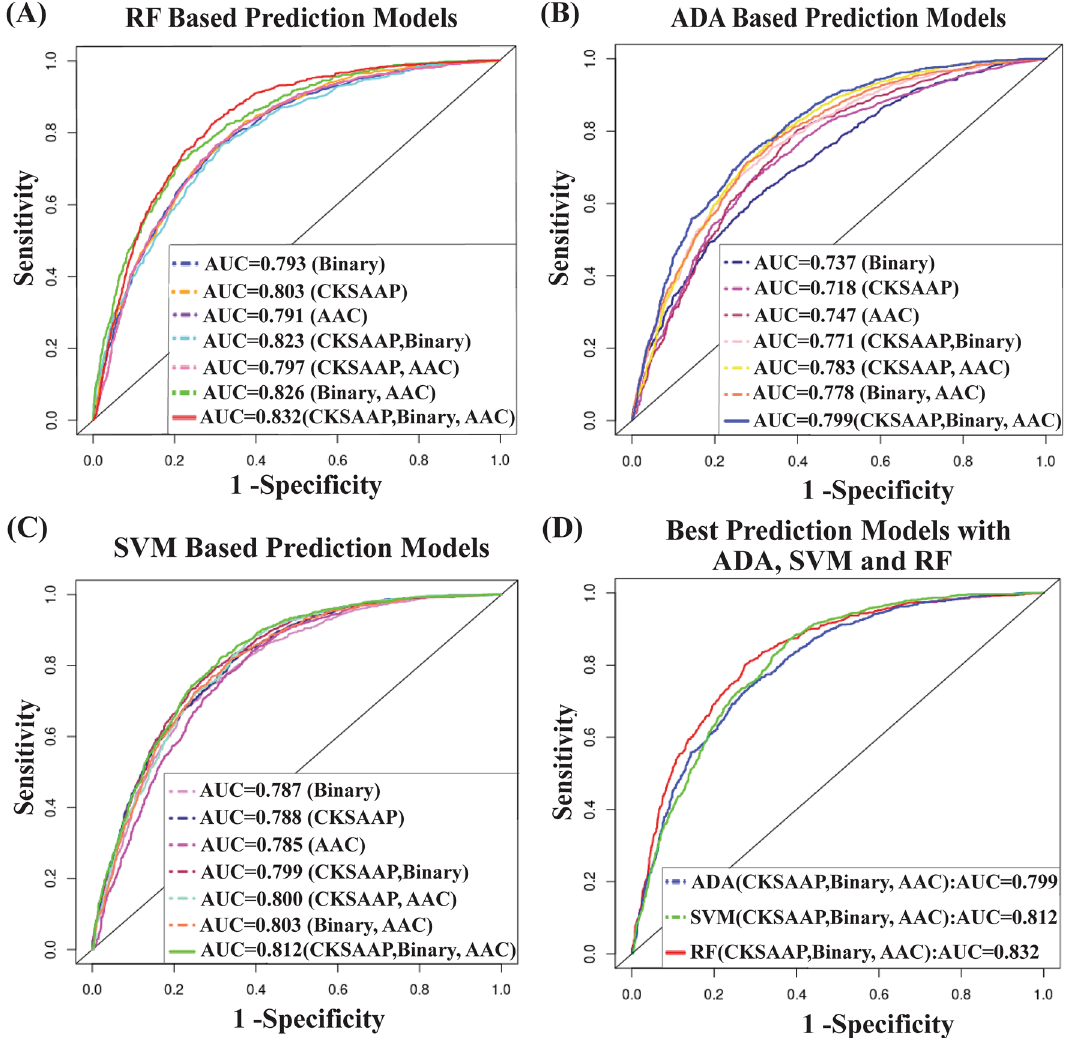
Figure 3. Performance of 21 prediction models by 5-fold CV results based on the training dataset that was consisted of 1:2 ratio of positive and negative samples. ( A ) ROC curves with the RF based 7 different prediction models, ( B ) ROC curves with the ADA based 7 different prediction models, ( C ) ROC curves with the SVM based 7 different prediction models, and ( D ) ROC curves for the best prediction models with ADA, SVM, and